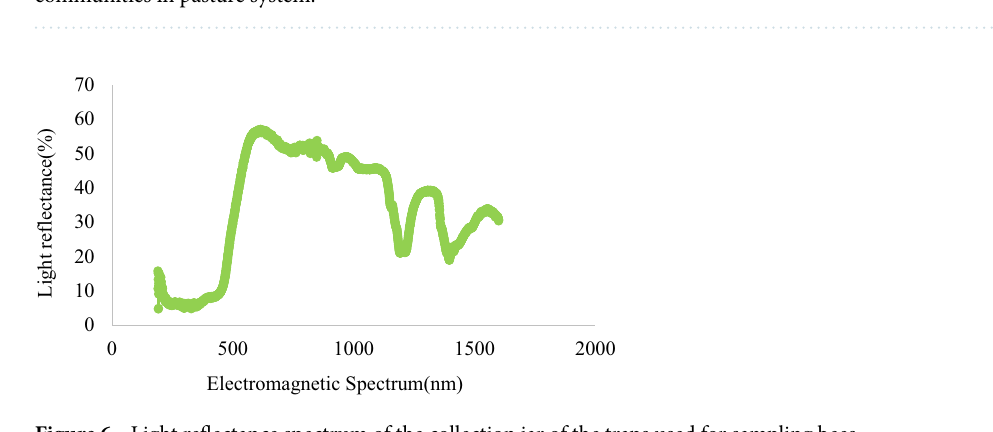
Figure 5. Light reflectance spectrum of different colored vanes of passive traps used for sampling bee communities in pasture system.